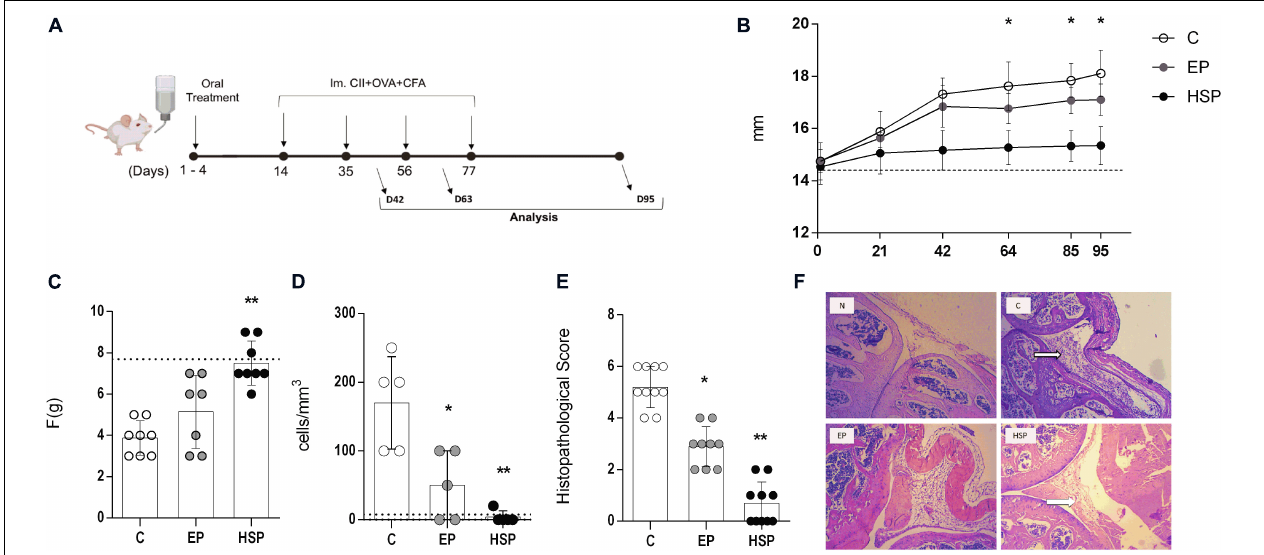
FIGURE 1 | Oral administration of Hsp65-producing L. lactis prevented collagen-induced arthritis in mice. (A) Schematic protocol for the chronic model of collagen-induced arthritis. BALB/c mice were fed either XM17 broth only (C group), EP-Lac (EP group) or Hsp65-Lac (HSP group) for four days. Ten days later, arthritis was induced with four injections of CII+OVA in CFA; at day 95 all mice were euthanized. (B) Average edema of both hind paws was measured with a pachymeter weekly. Graphs are representative of three combined independent experiments ( N = 16–17). Values from naïve unmanipulated mice are shown as a dashed line (C) Mechanical nociceptive threshold was quantified using an Analgesy-meter (Ugo Basile, Italy) at the day 95 ( N = 8). (D) Leukocytes in the synovial cavity were counted after the cavity of the left knee was washed, and the number of total leukocytes (cells/mm 3 ) was represented by bars ( N = 5). (E) Histopathological score based on inflammatory infiltrate, pannus, cartilage, and bone erosion was evaluated ( N = 10). (F) Histological sections of the knee collected at day 95 and stained with HE. 100 × magnification. The arrow indicates the inflammatory infiltrate in the synovial cavity. Values represent the mean ± SEM. * p < 0.05. ** p < 0.005 *** p < 0.0005 in comparison to control